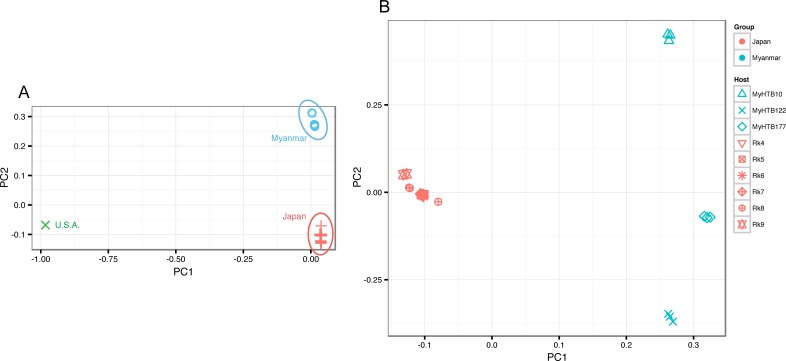
Principal component analyses of variant data.(A) a plot including the reference genome strain (USA). Variances represented by PC1 = 40.1% and PC2 = 14.1%. (B) Japanese and Myanmar samples only. Variance represented by PC1 = 28.4% and PC2 = 10.3%. Totals of 234,398 and 128,040 variant positions were included in the PCA analysis for Fig 2A and 2B, respectively.